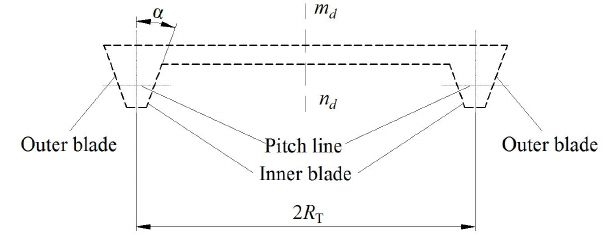
Figure 2. Conventional large gear milling cutter.